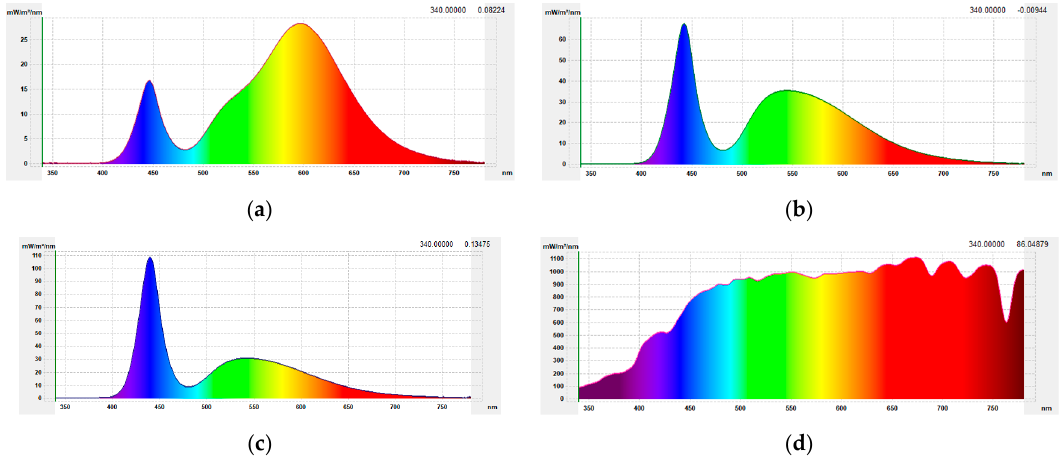
Figure 1. Spectrum emitted by Light Emitting Diode (LED) diodes and the sun: ( a ) warm white (3200 K); ( b ) cold white (6500 K); ( c ) very cold white (8500 K); ( d ) the sun (in the range of 350 nm to 800